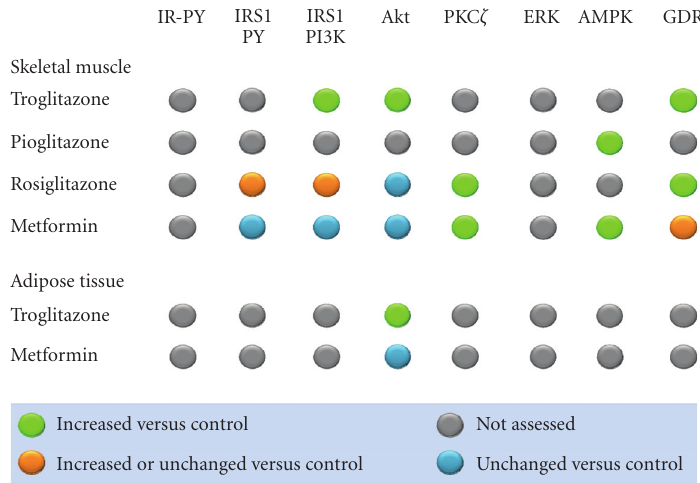
Figure 3: E ff ects of TZDs and metformin on activation of insulin signaling proteins in tissues from individuals with type 2 diabetes. The e ff ects of troglitazone, pioglitazone, and rosiglitazone on various proteins involved in insulin signaling in skeletal muscle and adipose tissue are indicated. The e ff ects of metformin are also shown for comparison. GDR indicates the glucose disposal rate, as a measure of insulin sensitivity. IR-PY: insulin receptor tyrosine phosphorylation; IRS1: insulin receptor substrate-1; PY: tyrosine phosphorylation; PI3K: phosphatidylinositol 3 kinase. Adapted from [26–33].